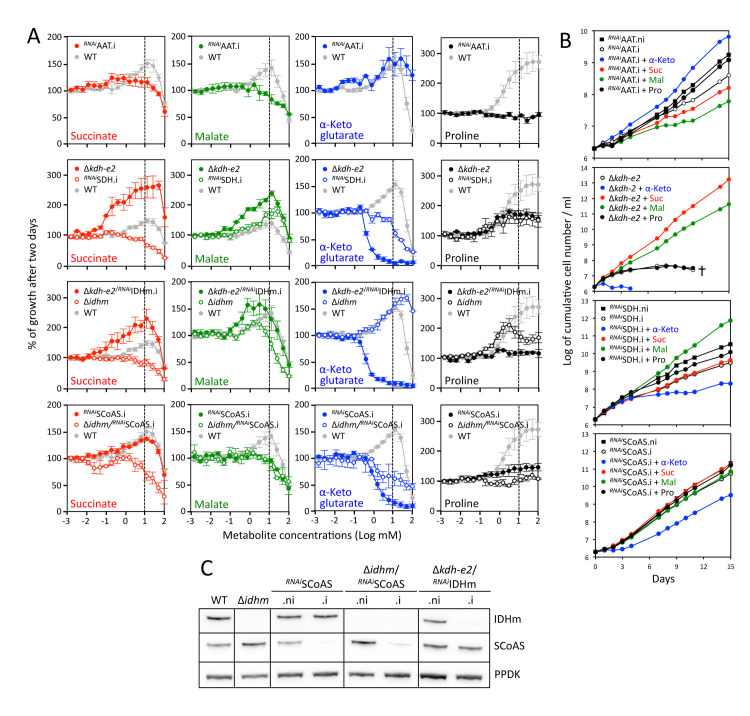
α-ketoglutarate is toxic for the Δkdh-e2, RNAiSCoAS.i and RNAiSDH.i cell lines.Panel A compares the effect of succinate, malate, α-ketoglutarate or proline (10 mM) on growth of the parental and mutant cell lines in glucose-depleted medium containing 2 mM proline, using the Alamar Blue assay described in Fig 4. Panel B shows growth curves of the RNAiAAT, Δkdh-e2, RNAiSDH and RNAiSCoAS cell lines incubated in glucose-depleted medium containing 2 mM proline, in the presence (colored circles) or absence (open circles) of α-ketoglutarate, malate, succinate or proline (10 mM) (.i, tetracycline-induced cells;.ni, non induced cells). Cells were maintained in the exponential growth phase and cumulative cell numbers reflect normalization for dilution during cultivation. Panel C shows Western blot analyses with the immune sera indicated in the right margin of the parental (WT), Δidhm and tetracycline-induced (.i) and non-induced (.ni) RNAiSCoAS, Δidhm/RNAiSCoAS and Δkdh-e2/RNAiIDHm cell lines.